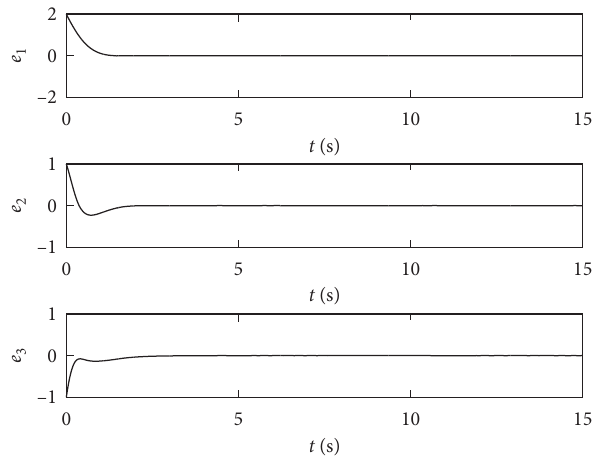
Figure 9: Synchronization